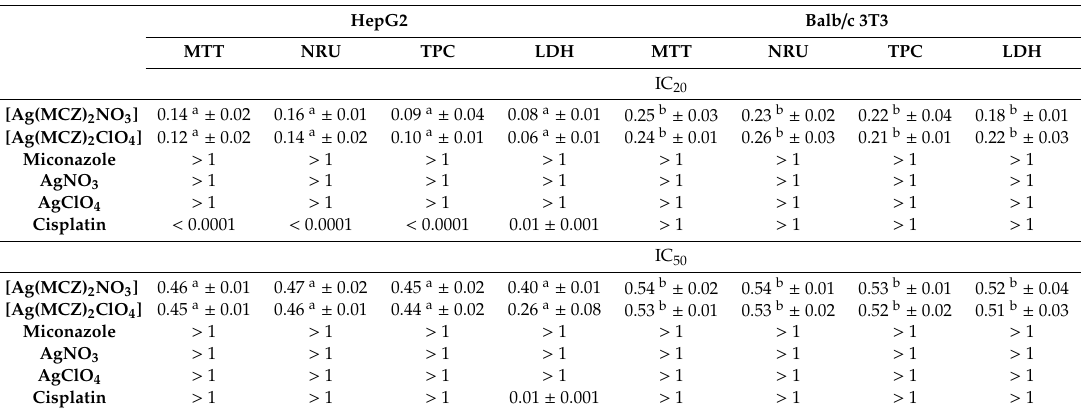
Table 6. Cytotoxicity concentrations (IC 20 and IC 50 , µ M) determined in HepG2 Balb / c 3T3 cells by